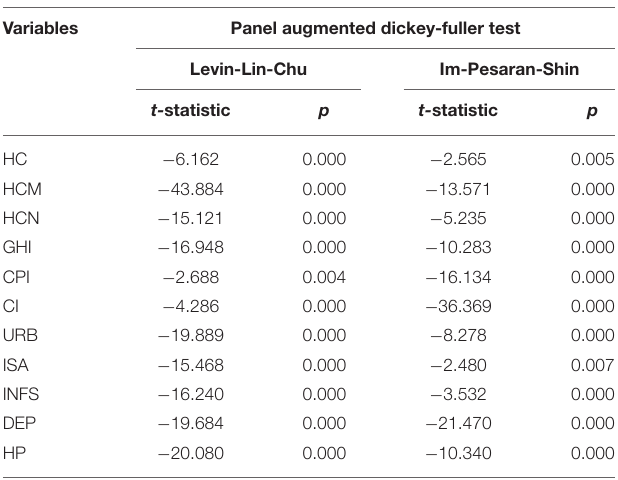
TABLE 2 | Panel unit root tests.